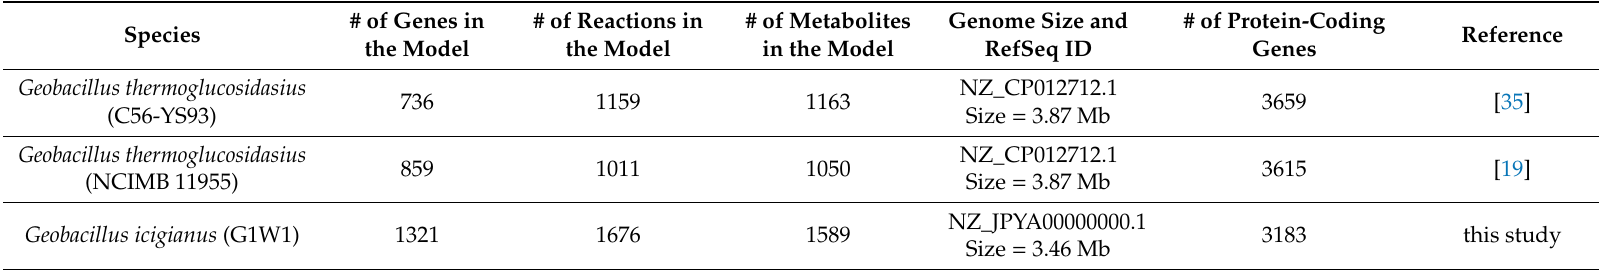
Table 1. Network statistics for published genome-scale models of Geobacillus strains and comparison with iMK1321